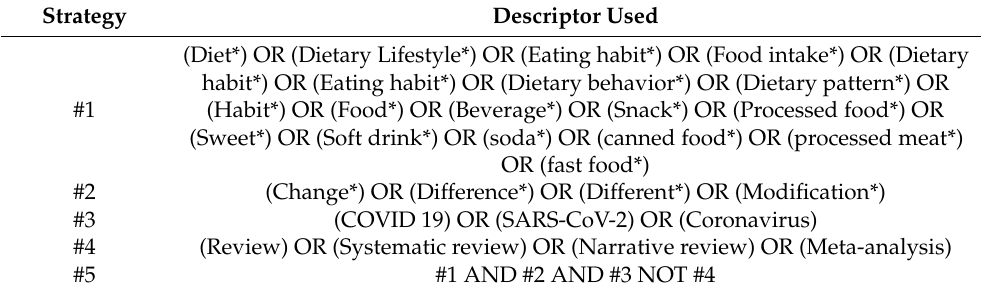
Table 1. Search strategy used in the US National Library of Medicine (PubMed) and Medical Literature Analysis and Retrieval System Online (MEDLINE), and adapted to the other sources, according to selected